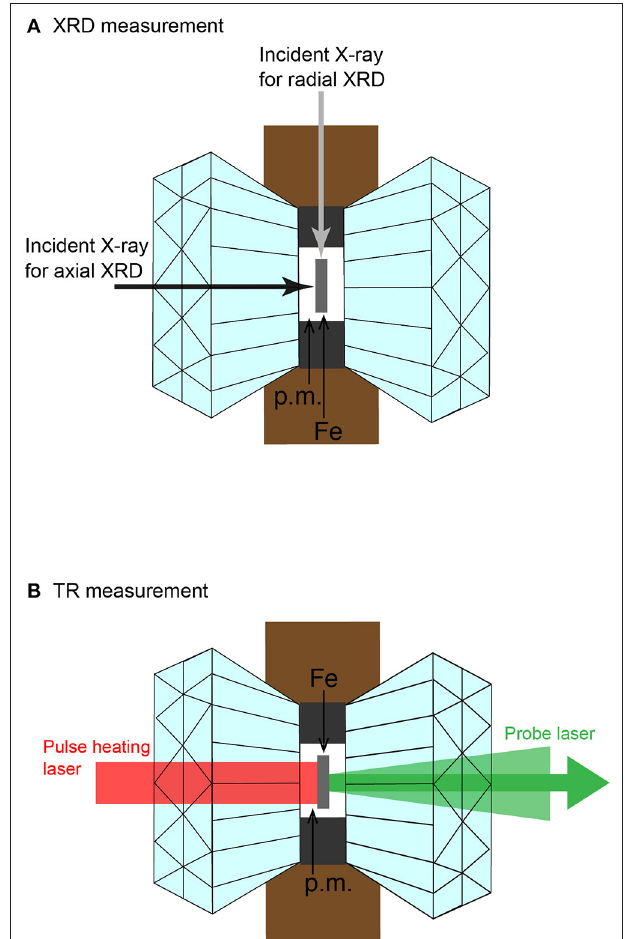
FIGURE 3 | Schematics of the experiment. (A) Directions of incident X-ray for axial and radial XRD measurements. (B) Ray paths of laser beams for thermoreflectance measurements in a DAC. p.m. indicates pressure transmitting